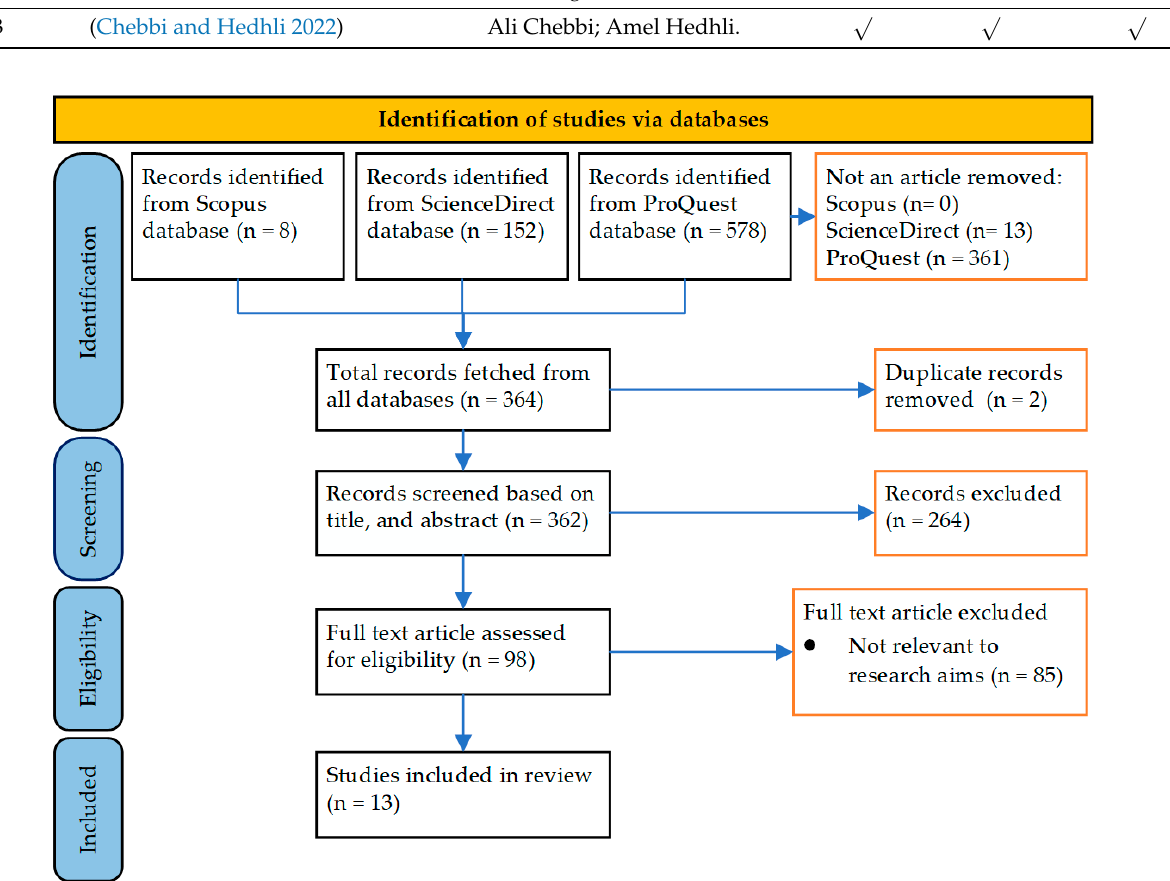
Figure 2. PRISMA flowchart.